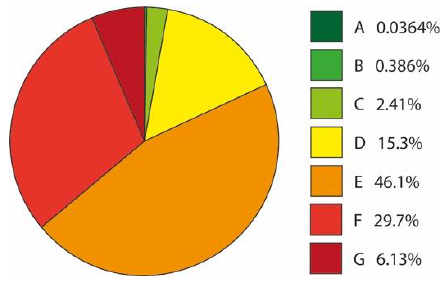
Figure 1. Share of the multifamily building stock 1945 – 1975 in each EPC rating A –